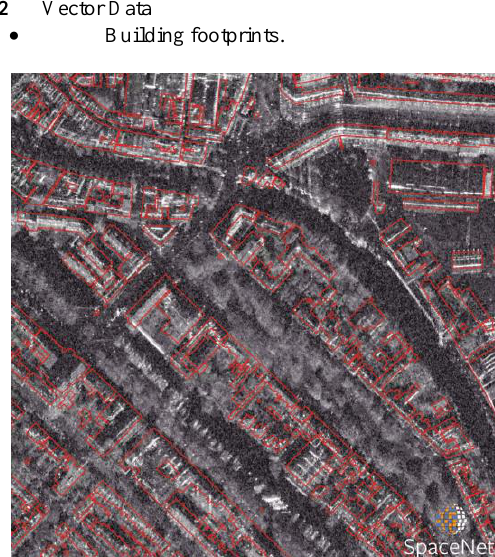
Figure 2. SAR Images with Building